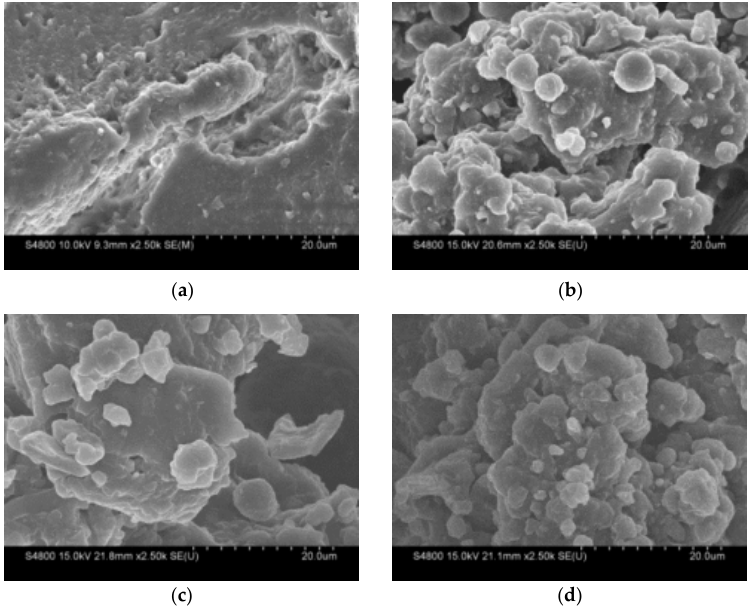
Figure 10. The infrared spectrum of the crumb rubber prepared by the heat activation treatment at different temperatures: ( a ) crumb rubber powder; ( b ) 160 °C + 60 min by heat treatment; ( c ) OMC ◦ C + 60 min by heat treatment; ( c ) OMC by by chemical treatment; and ( d ) mechanical force + OD by mechanochemical treatment. different temperatures: ( a ) crumb rubber powder; ( b ) 160 chemical treatment; and ( d ) mechanical force + OD by mechanochemical